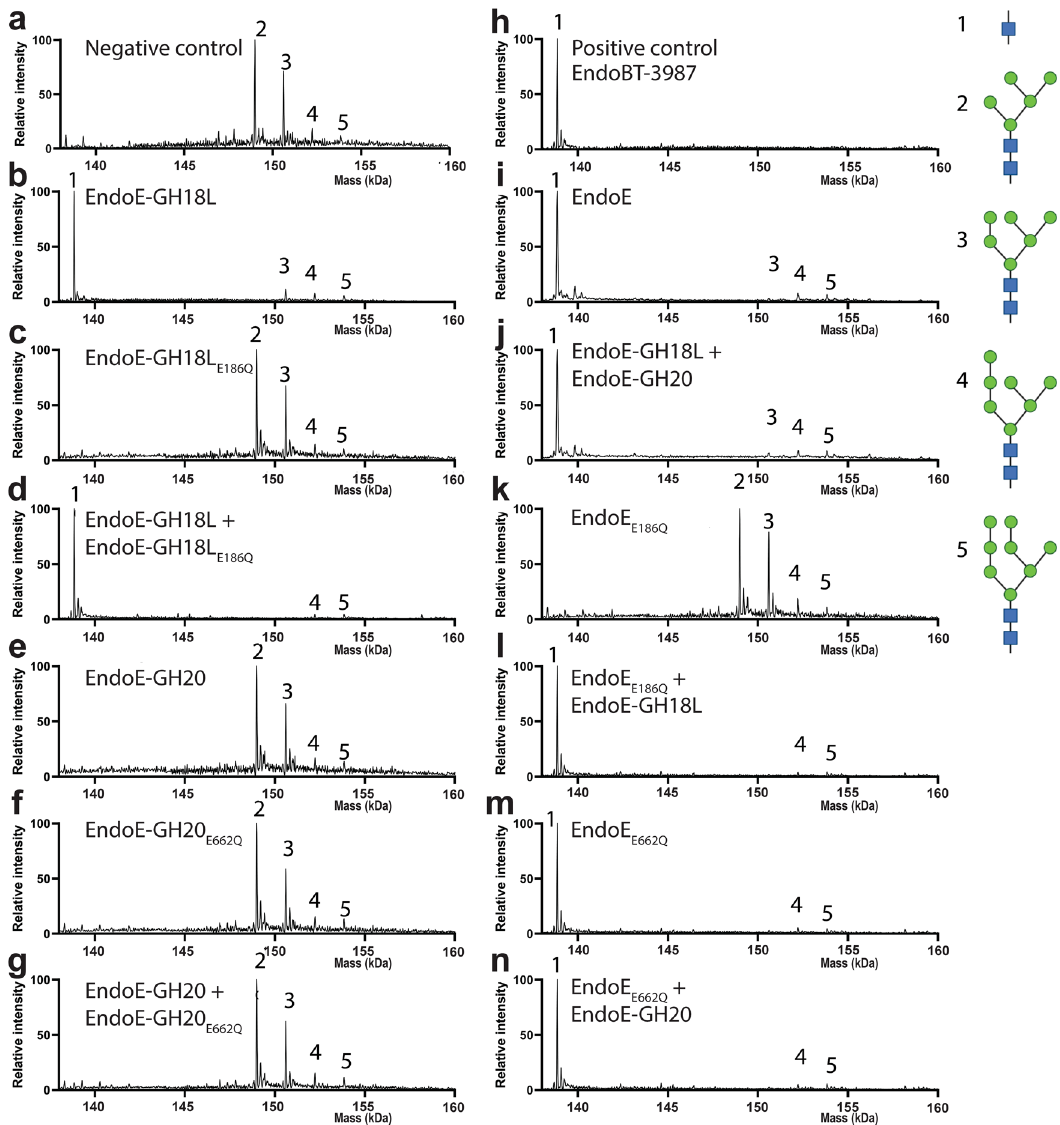
Fig. 6 Molecular basis of EndoE GH18 and GH20 domains substrate speci fi city as visualized by LC/MS. Processing of HM-type N -glycans on RNAse B. Mass spectrometry of RNAse B treated with a no enzyme (negative control) b EndoE-GH18L c EndoE-GH18L E186Q d EndoE-GH18L + EndoE-GH18L E186Q e EndoE-GH20 f EndoE-GH20 E662Q g EndoE-GH20 + EndoE-GH20 E662Q h EndoBT-3987 (positive control) i EndoE j EndoE-GH18L + EndoE-GH20 k EndoE E186Q l EndoE E186Q + EndoE-GH18L m EndoE E662Q n EndoE E662Q + EndoE-GH20. The peaks corresponding to intact RNaseB are numbered based on the glycoforms found in the single glycosylation site of the protein. The retention time for RNAseB was 2.1 min. For mass deconvolution, the following parameters were used in the BioCon fi rm software; 1000 – 2400 m/z and 130 – 160 kDa. The theoretical and observed mass of each annotated peak are in Supplementary Table